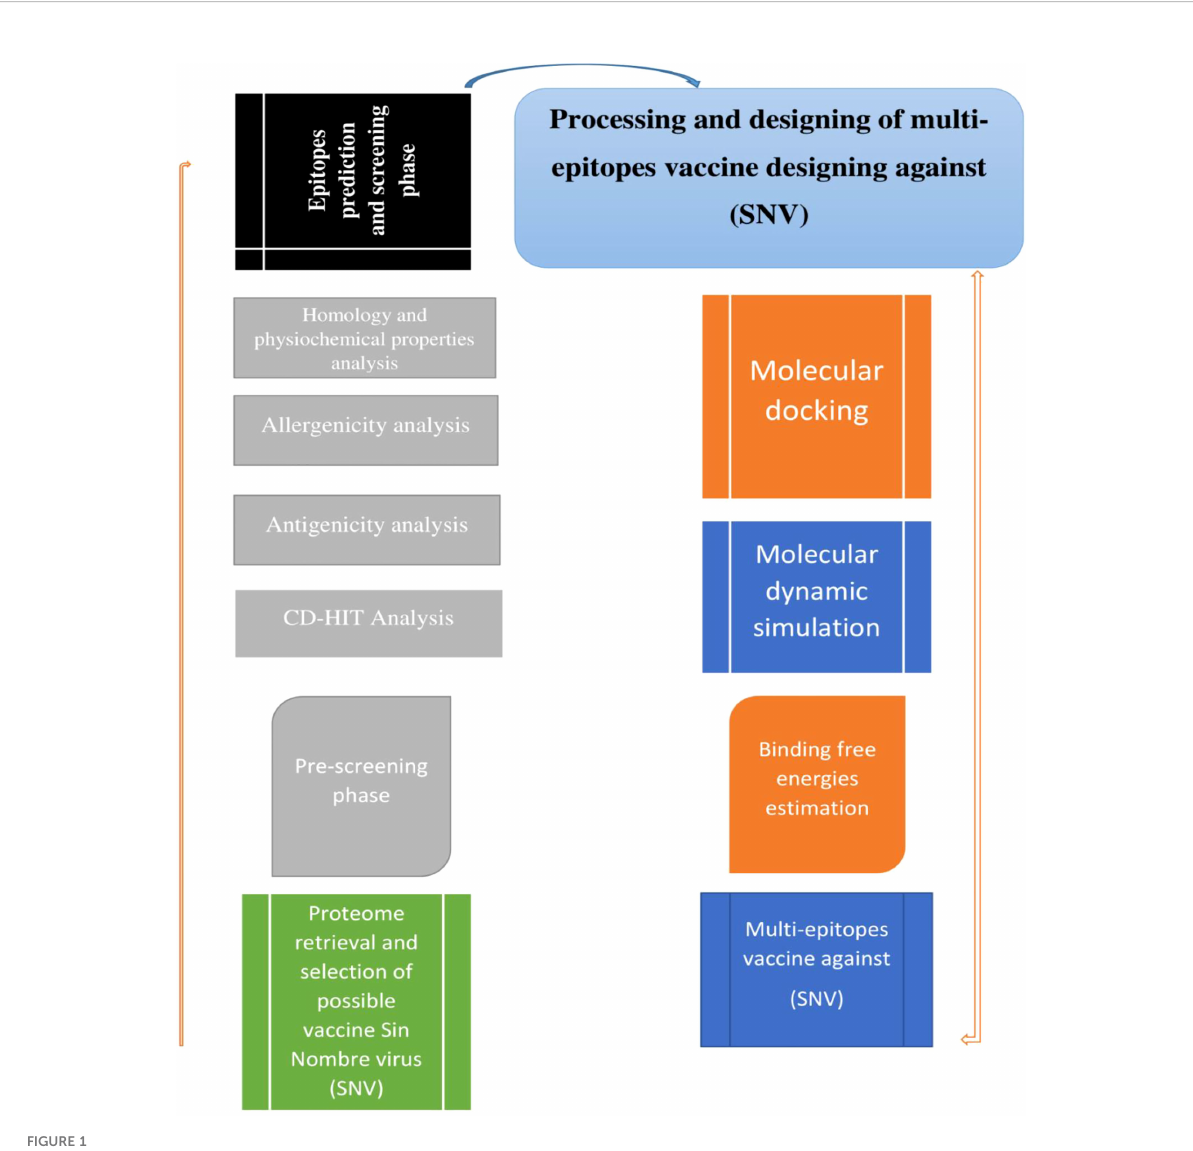
FIGURE 1 Schematic representation of research